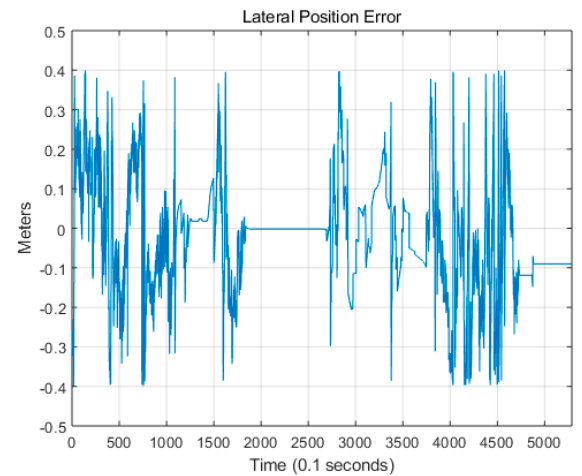
Figure 12. Lateral position error of the RTK/INS for a high-precision digital map.